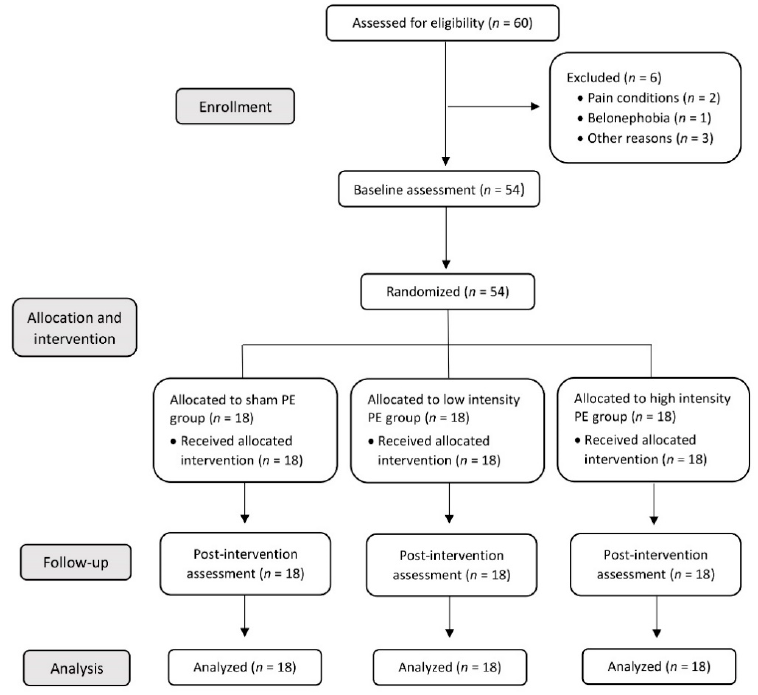
Figure 3. CONSORT flow diagram. Characteristics of the participants are summarized in Table 1. No statistically signif ‐ icant pre ‐ intervention differences in sociodemographic and outcome data were present between the groups. For text clarity, an in ‐ deep representation of the statistical results is presented in Table 2, where effect sizes are also reported. Table 1. Baseline demographic and outcome measures.